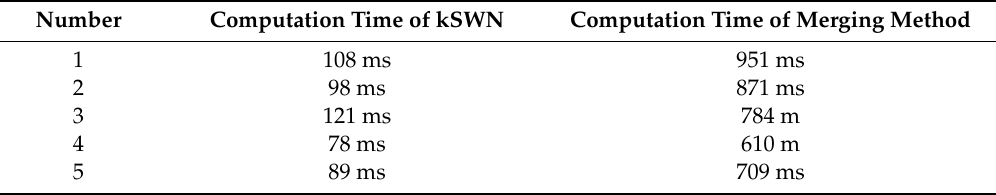
Table 4. The computation time of five